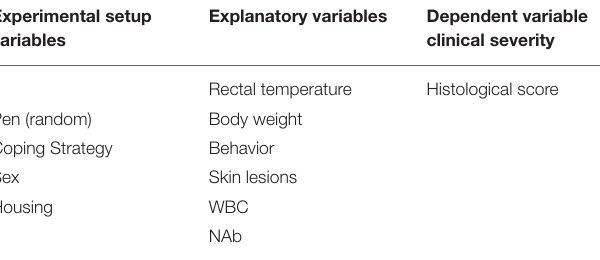
TABLE 3 | Overview of the used variables and disease